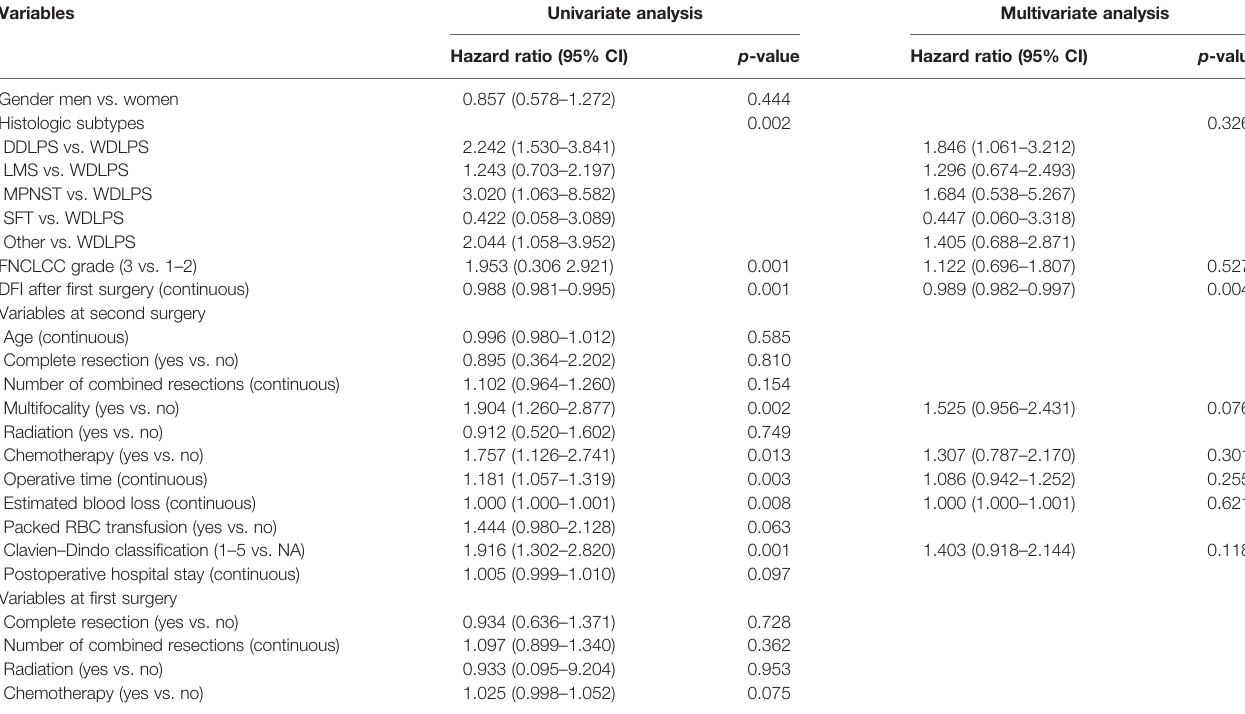
TABLE 3 | Univariable and multivariable analyses to determine the independent predictors of disease recurrence. Variables Univariate analysis Multivariate analysis Hazard ratio (95% CI) Hazard ratio (95% CI) p -value Gender men vs.